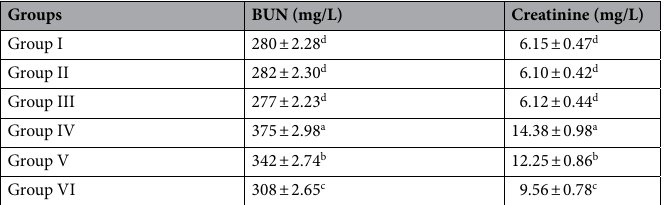
Table 3. Effects of AFB 2 and resveratrol on BUN and creatinine levels. Values are shown as mean ± SEM (n = 6). Group I: control, Group II: 10 mg/kg b.w resveratrol, Group III: 20 mg/kg b.w resveratrol, Group IV: 20 µg/kg b.w AFB 2 , Group V: 10 mg/kg b.w resveratrol + 20 µg/kg b.w AFB 2 , Group VI: 20 mg/kg b.w resveratrol + 20 µg/kg b.w AFB 2 . Data shown with different letters (a–d) in the same column are statistically significant (p <